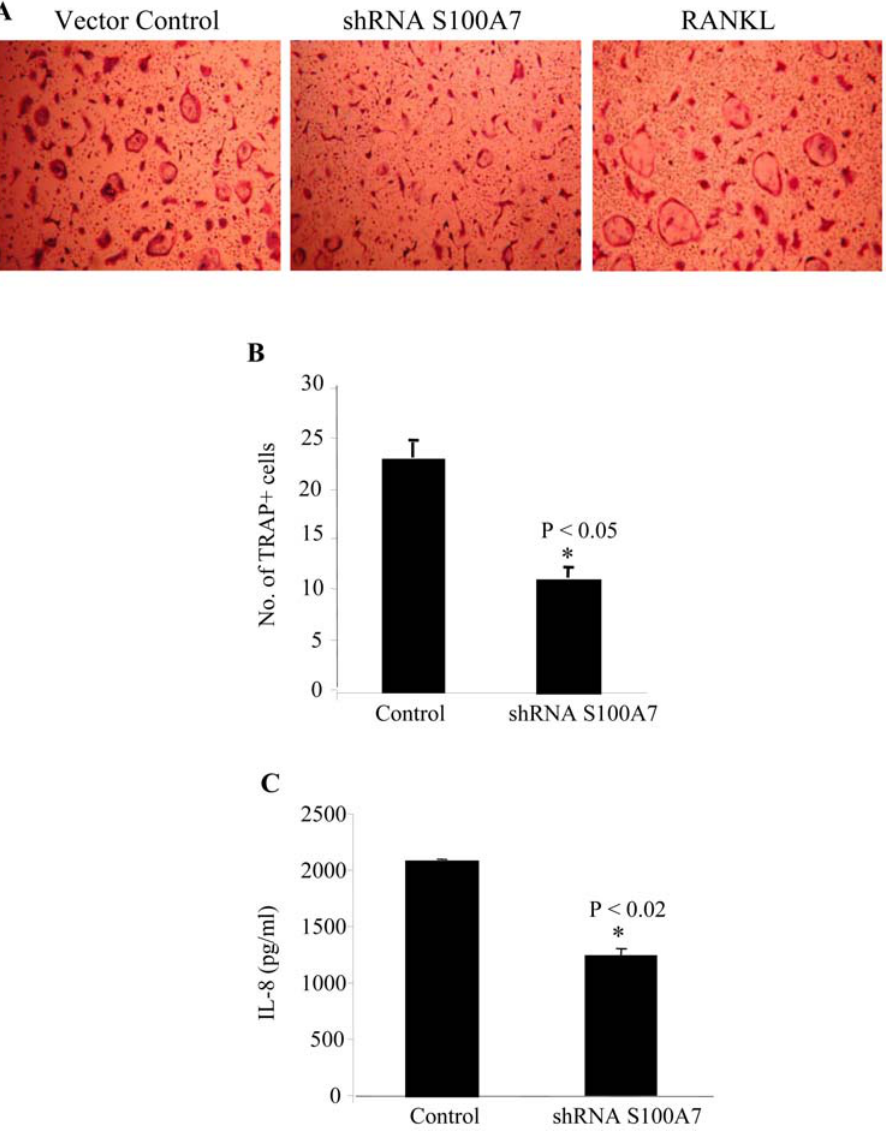
Figure 6. S100A7-downregulated cells decrease osteoclast formation and IL-8 expression levels. Osteoclast precursors were prepared (as described in Materials and Methods), plated in 24-well plates and allowed to stand for 5–6 hours. (A) Inserts containing 5 6 10 4 vector control cells, the S100A7 shRNA (downregulated) cells or RANKL without breast cancer cells (internal positive control) were then placed on the wells and the numbers of TRAP + multinucleated cells generated under each condition were counted at the end of 48 hours. Each culture was done in triplicate. The experiments were repeated thrice with similar results. (B) The number of multinucleated fused osteoclast cells (A) in an average of triplicate wells is represented in the histogram. Results are expressed as the mean 6 SEM (*p , 0.05). (C) Vector control and S100A7 shRNA-transfected stable MDA- MB-468 cell lines were grown to 80% confluence and supernatants were analyzed for IL-8 expression by ELISA. IL-8 expression was significantly less (*p , 0.02) in the S100A7-downregulated cells as compared to the vector-transfected